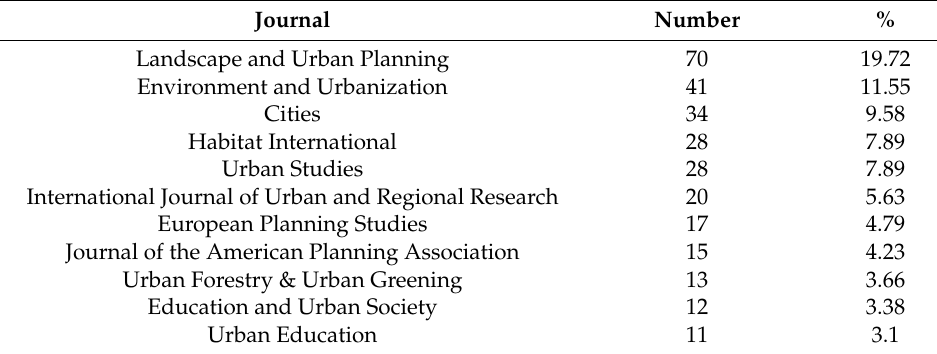
Table 4. The top 11 journals source for urban resilience research according to the 355 publications retrieved from the WOS core collection